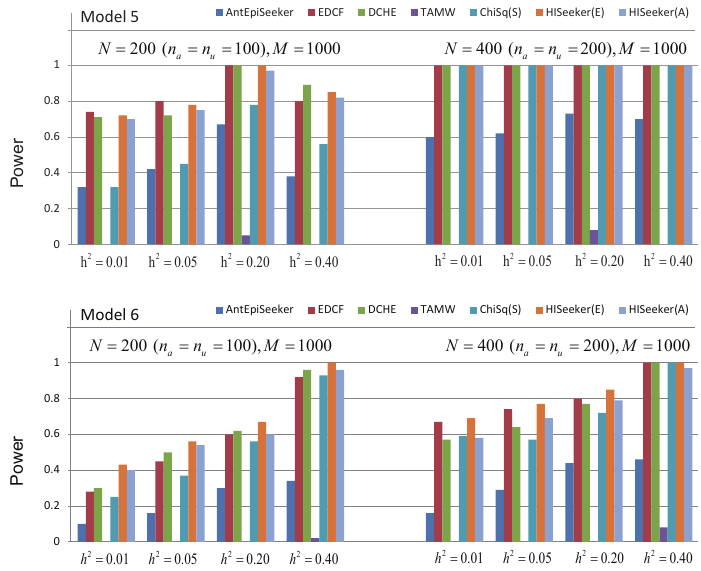
Figure 5. Powers of AntEpiSeeker, EDCF, DCHE, TAMW, ChiSq(S), HiSeeker(E) and HiSeeker(A) on two disease models without a marginal effect under different genetic heritabilities and sample sizes. The absence of a bar indicates no